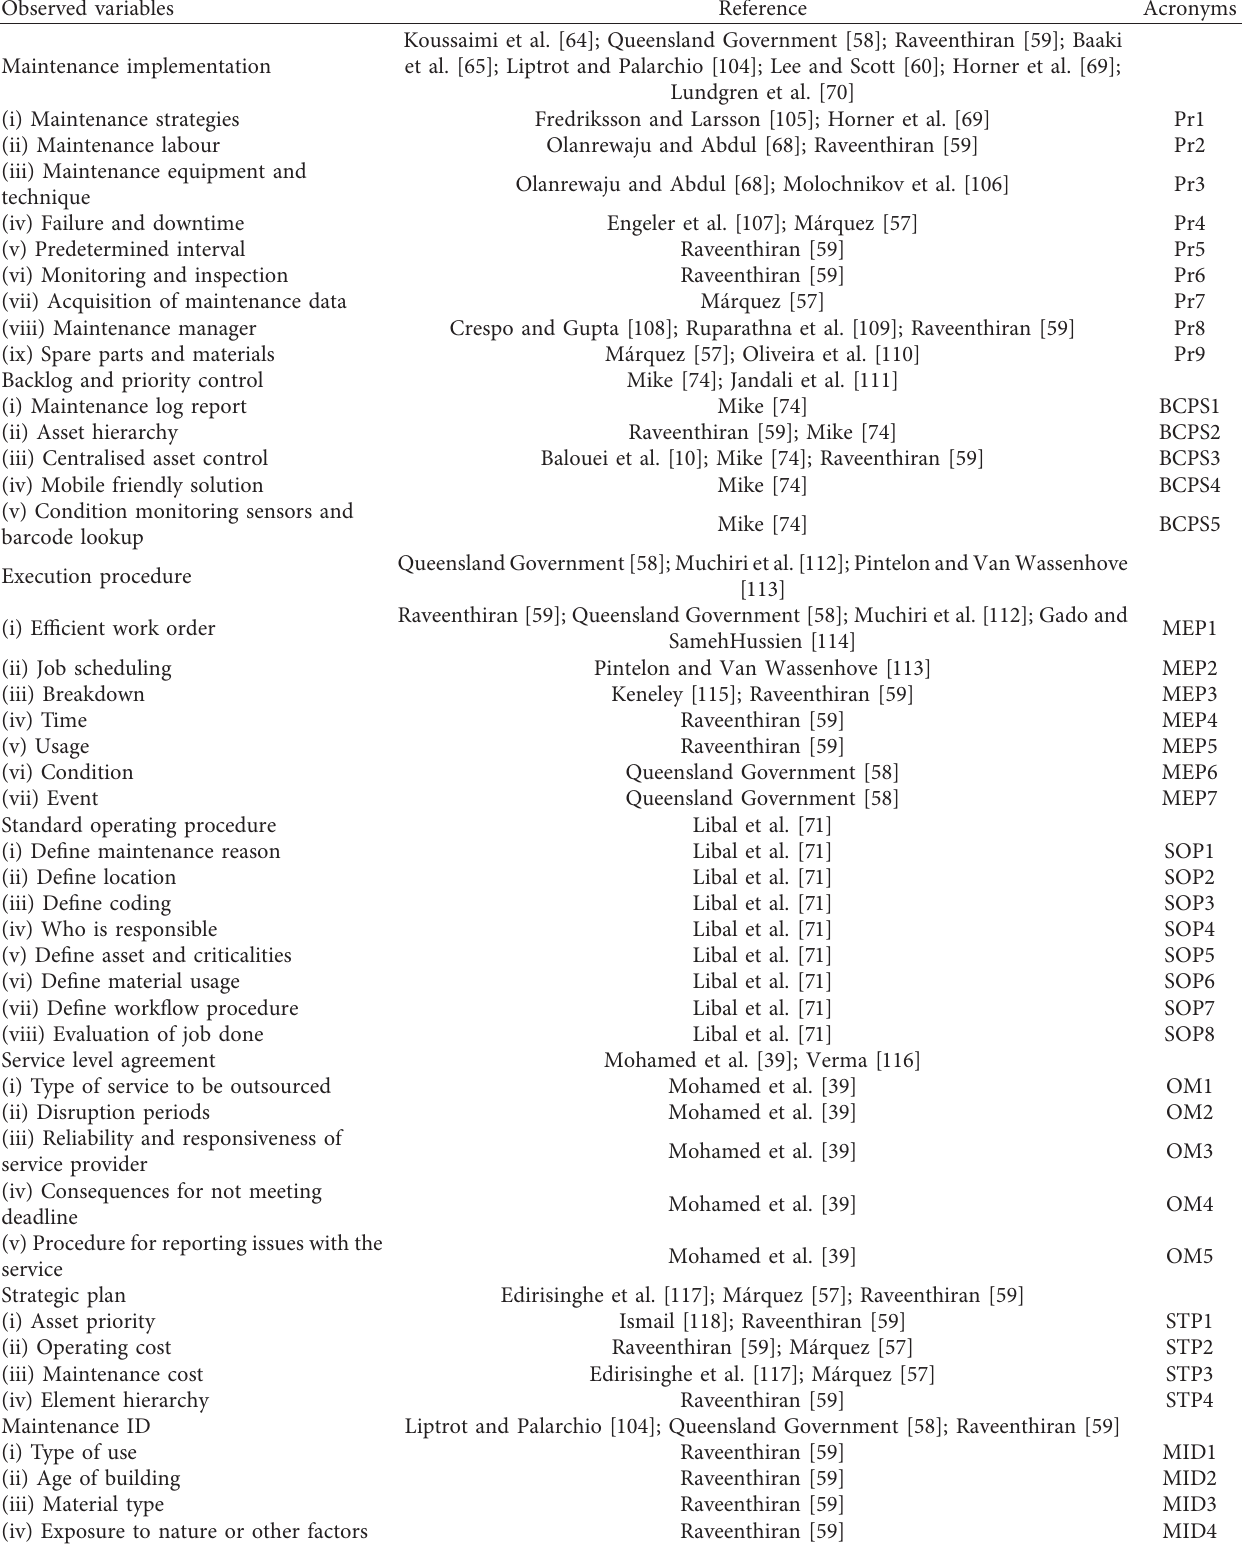
Table 1: Important supportive organisational